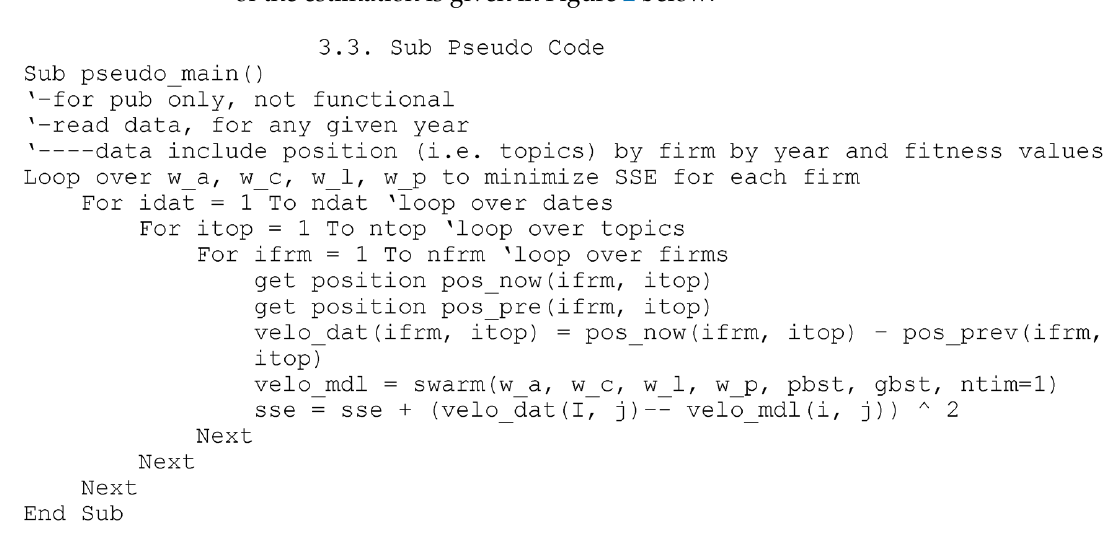
Figure 2. Pseudo code of the estimation.